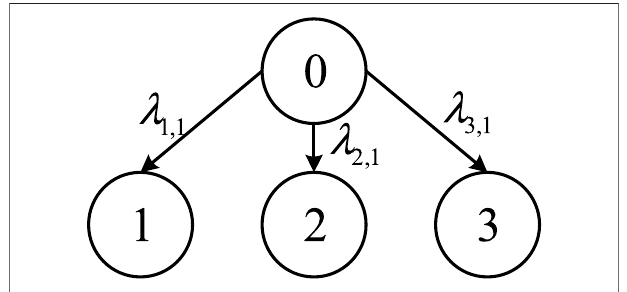
FIGURE 6 | Process of subsystem state